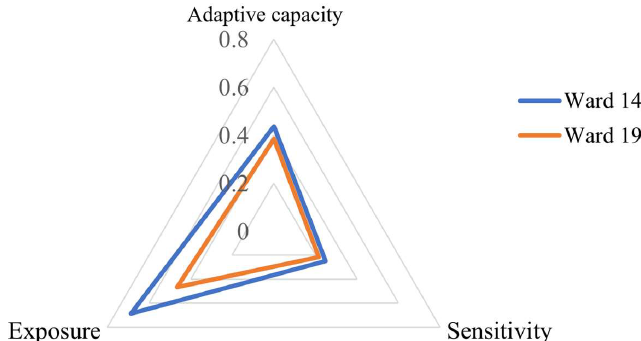
Figure 3. Triangle diagram for contributing factors of LVI-IPCC.